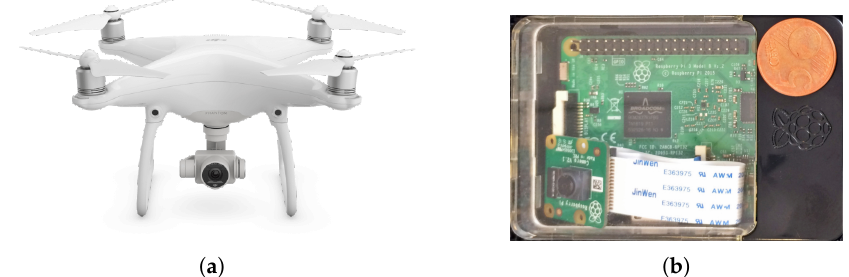
Figure 2. Original UAV used to capture the images and tested embedded board. ( a ) DJI Phantom4. ( b )